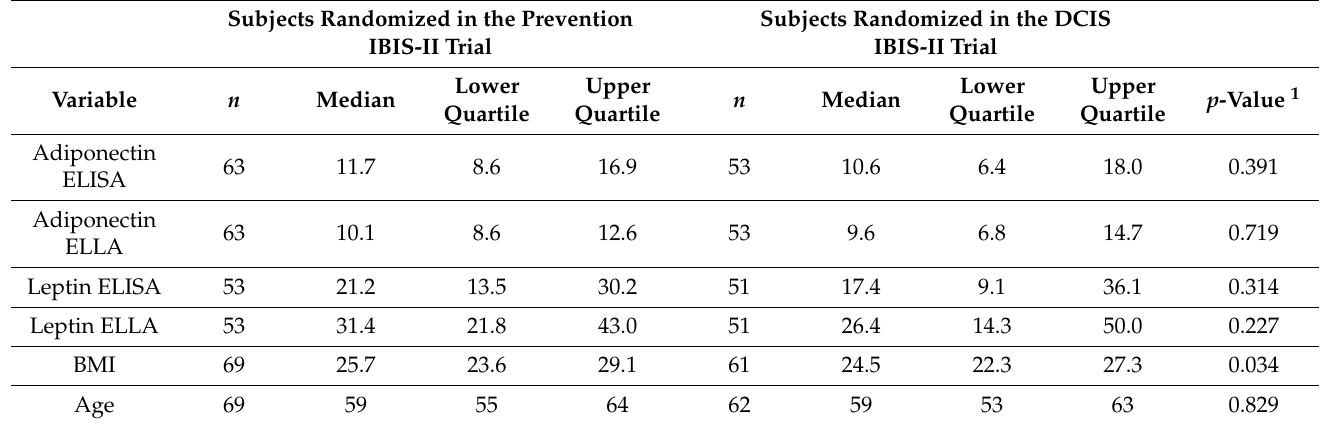
Table 1. Baseline characteristics of subjects.